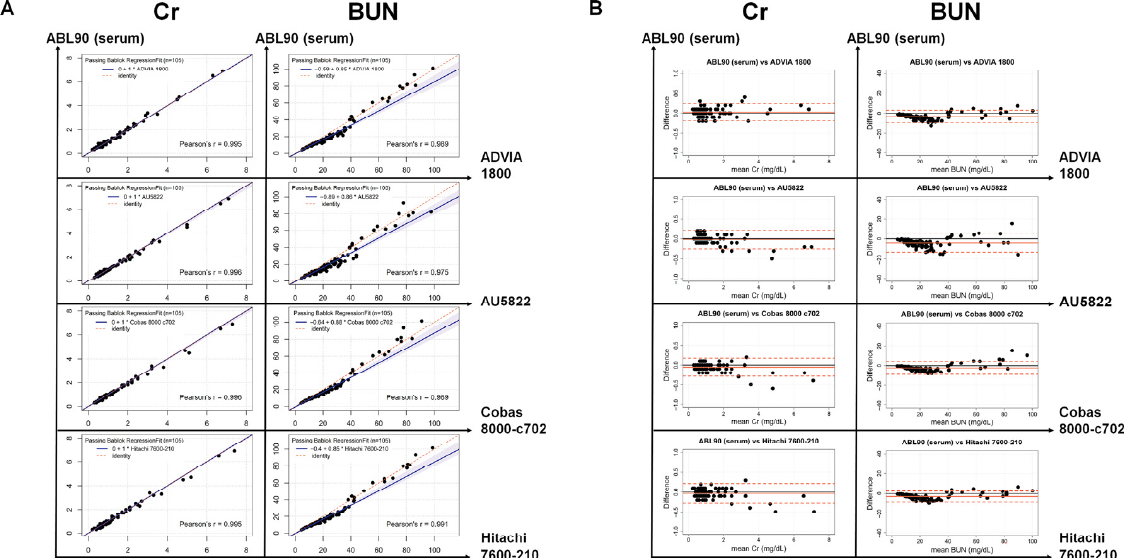
Figure 3. Passing–Bablok regression ( A ) and Bland–Altman plot ( B ) of Cr and BUN testing comparing the four automated chemistry analyzers and the ABL90 FLEX PLUS using serum. ( A ) The blue- colored area represents the 95% CI of the regression line. ( B ) The black and orange solid lines indicate the zero and mean differences, respectively. The dashed orange line represents the two SDs of the mean difference. Cr: creatinine; BUN: blood urea